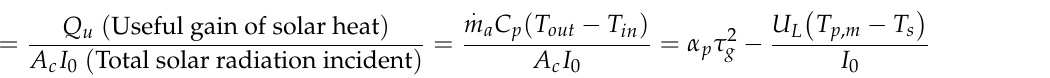
. m b Right-Hand Side